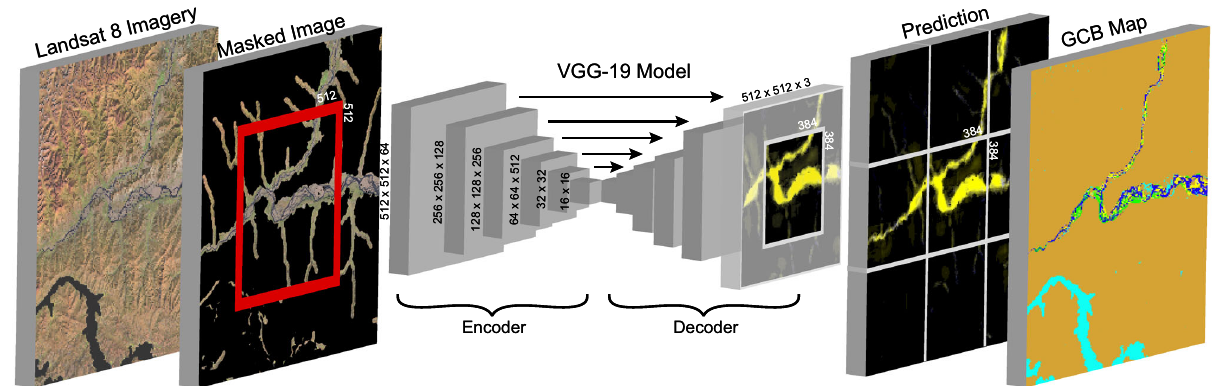
Fig. 2 | Global Channel Belt model — The Global Channel Belt (GCB) model is based on a VGG-19 36 machine learning algorithm for pattern recognition of channel belt extent and single- or multi-threaded river character. The algo- rithmuses512×512pixeltilesofLandsat8imagesmaskedfornon-riverineregions using a series of convolutions and upscaling functions to simplify the prediction